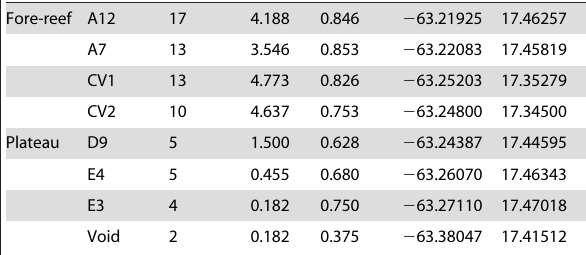
Transects in Saba Bank’s fore-reef environment (A12 - CV2) had significantly more gorgonians, and higher diversity (Mann-Whitney U Test, P , 0.01) than transects in the plateau environment (D9 - Void). Richness is the number of octocoral species present. Density values are in colonies m 2 2 . The diversity measure is Simpson’s index (in the natural log form).